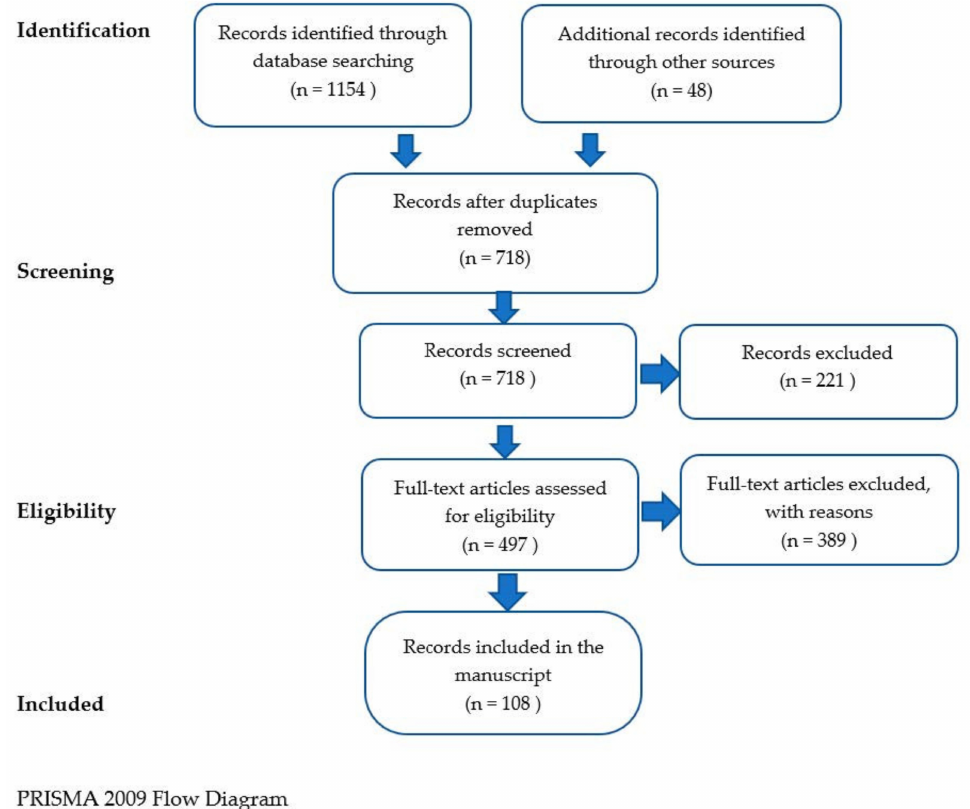
Figure A1. PRISMA 2009 flow diagram for searching the